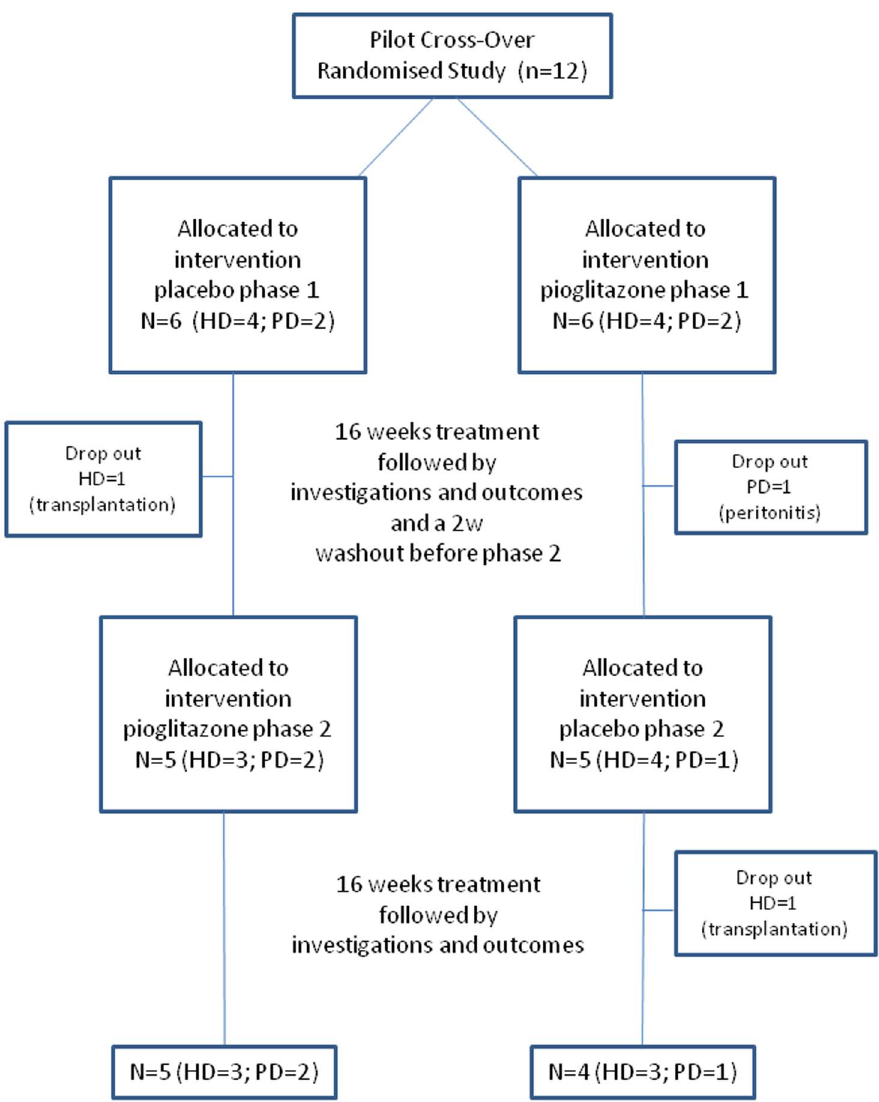
Figure 1. Flow chart of the double blinded cross-over study.